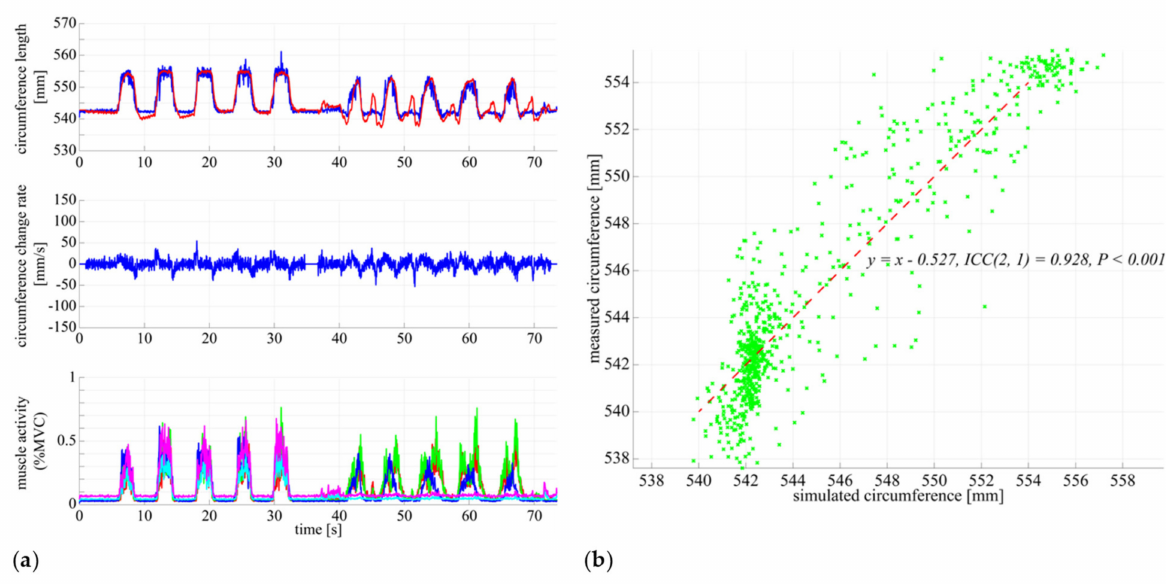
Figure 8. Relationship between EMG and stretch length. ( a ) Measured stretch length, velocity, muscle activity and estimated stretch length during the muscle co-contraction at static standing posture and squat motion. The horizontal axis represents time (s) and the vertical axis represents the stretch length (mm) in top, stretch velocity (mm/s) in middle, and muscle activity normalized by MVC in bottom. The red line represents the measured stretch length and the blue one represents the estimated one. ( b ) Relationship between the simulated and measured stretch lengths. The horizontal axis represents the simulated stretch length (mm) and the vertical axis represents the simulated stretch length (mm). The green cross represents the data sampled in 10 Hz and the red line represents the regression line between these two